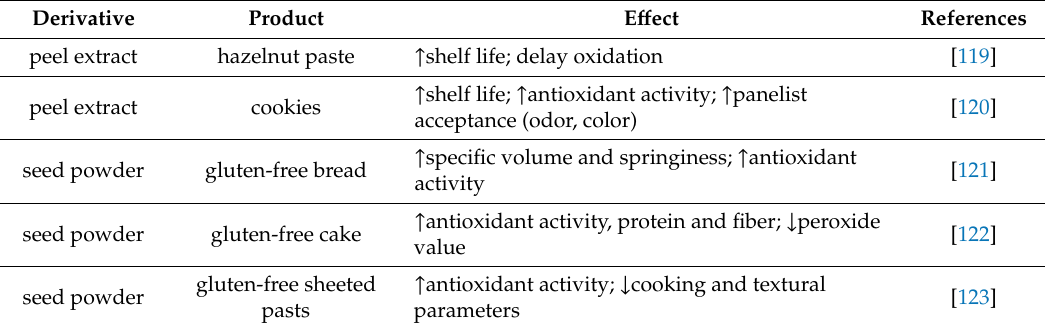
Table 9. Recent studies on the e ff ect of the addition of pomegranate derivatives to cereal and nut